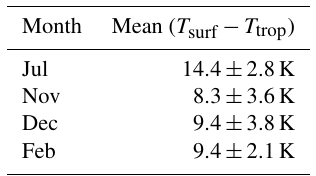
Table 2. Mean values and SDs of T surf − T trop obtained from the